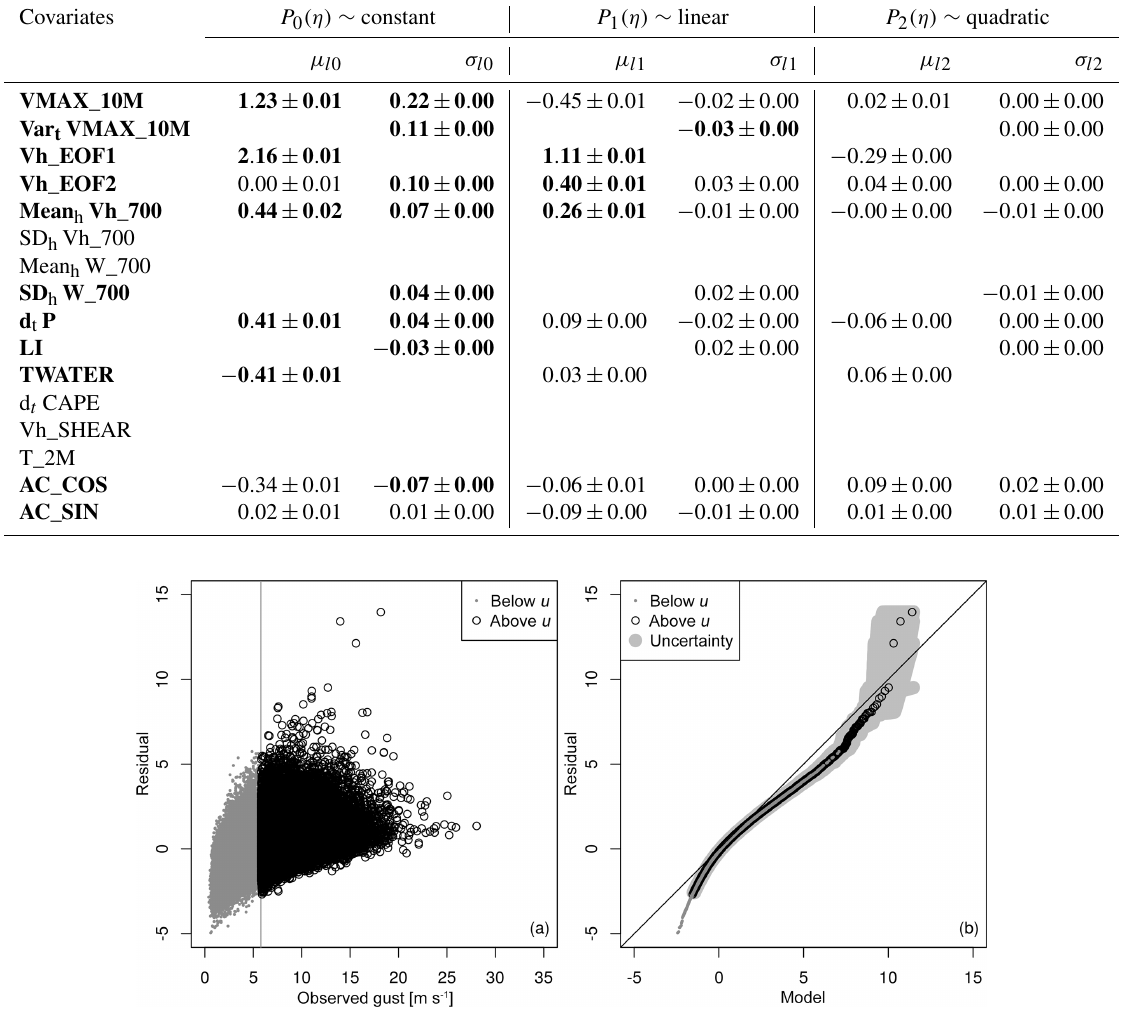
Table 2. Estimates of the regression coefficients using the Legendre model with K = 2. Estimates are derived without penalization includ- ing the selected covariates. Mean and standard deviation are derived from the 11 estimates using cross-validation. Bold text indicates the parameters that resisted the LASSO penalization. No value is given if the variable is not included in the Legendre model. Covariates